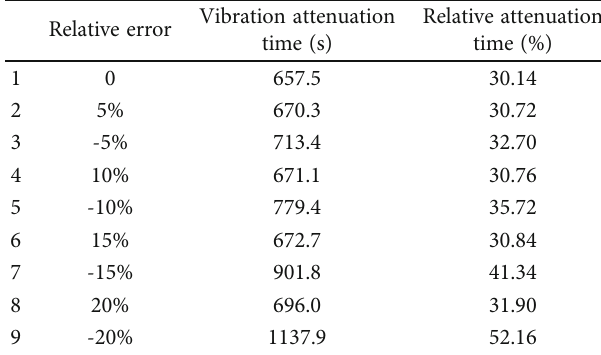
Table 2: Vibration suppression e ff ect under di ff erent relative error